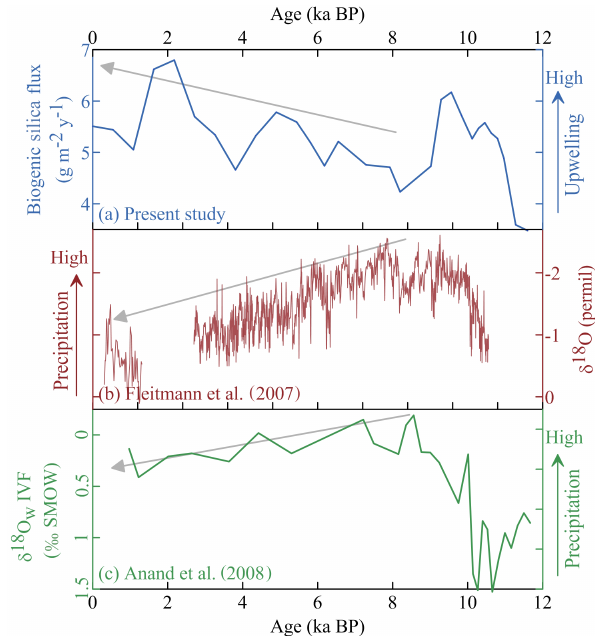
Figure 10. A comparison of the Somali upwelling with SWM rainfall records during the Holocene. (a) The biogenic silica flux (present study), (b) the Oman speleothem record and (c) δ 18 O w IVF data from the eastern Arabian Sea. Grey arrows indicate the trend of the proxy record during the last